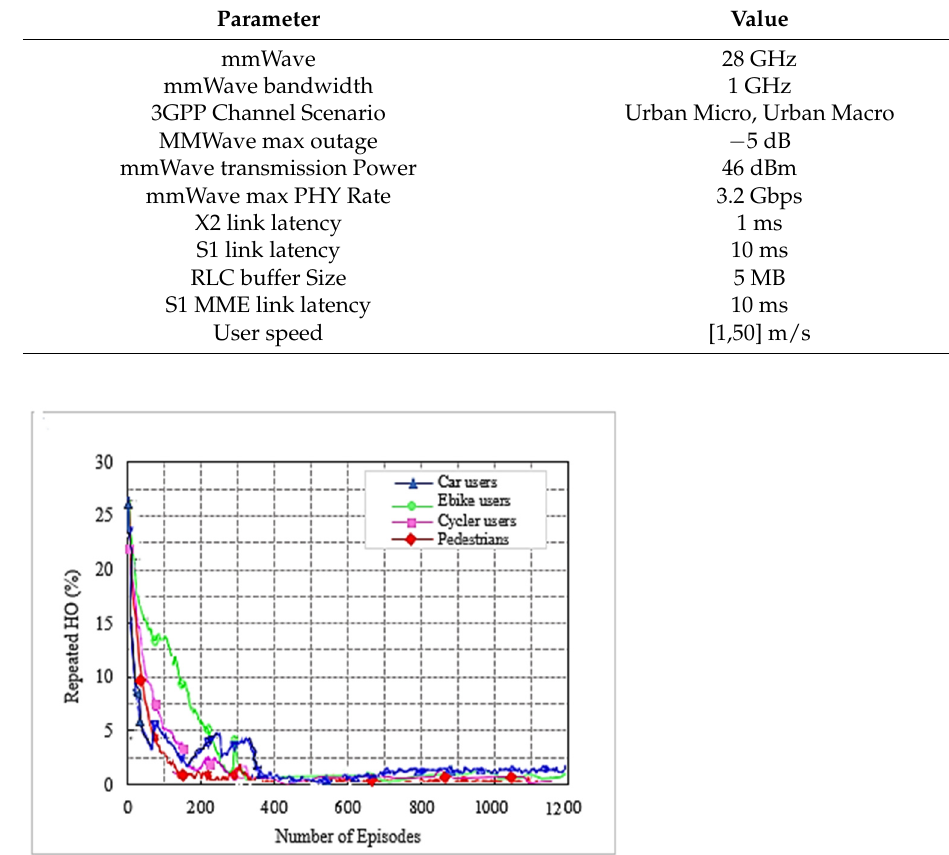
Figure 6. Number of wasteful HO as a function of the number of training episodes for JMLS– DDPG HO scheme . Figure 7. The cumulative reward as a function of the number of training episodes for DDPG only HO scheme according to user type.